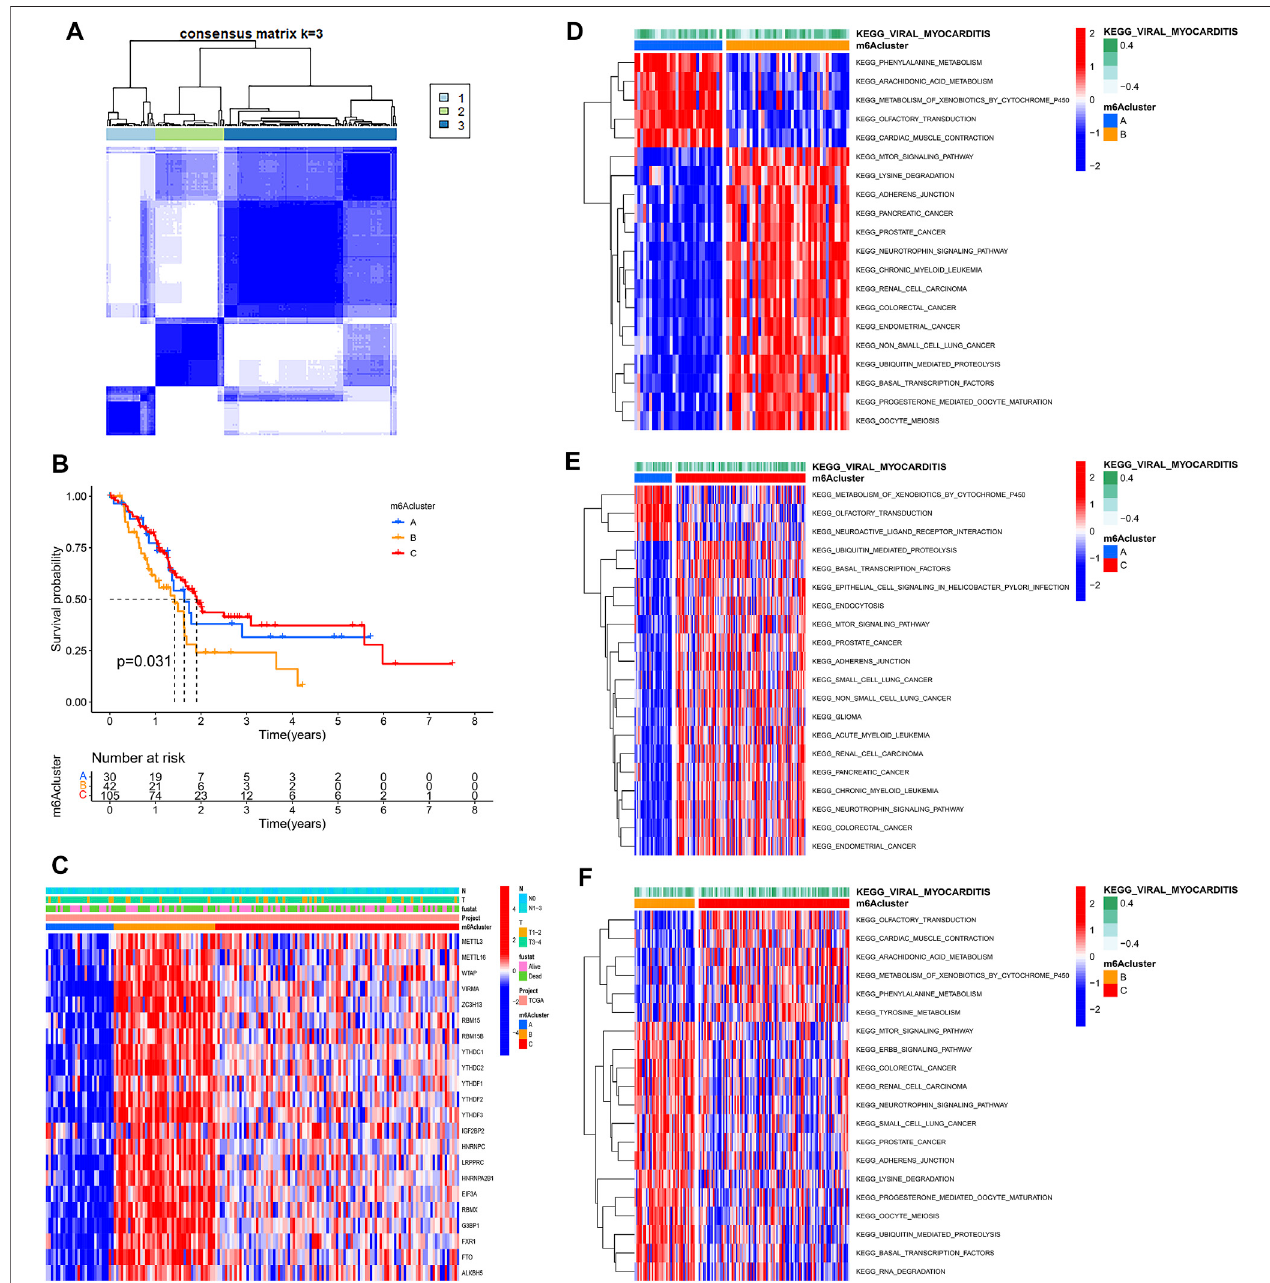
FIGURE 2 | Molecular characteristics of m6Aclusters. (A) Consensus clustering matrix for k (cid:1) 3; (B) KM analysis of patients in distinct m6Aclusters; (C) The heatmap depicted the expression levels of m6A regulators in distinct m6A clusters; (D) GSVA enrichment analysis between m6Acluster A and m6Acluster B; (E) GSVA enrichment analysis between m6Acluster A and m6Acluster C; (F) GSVA enrichment analysis between m6Acluster B and m6Acluster C.